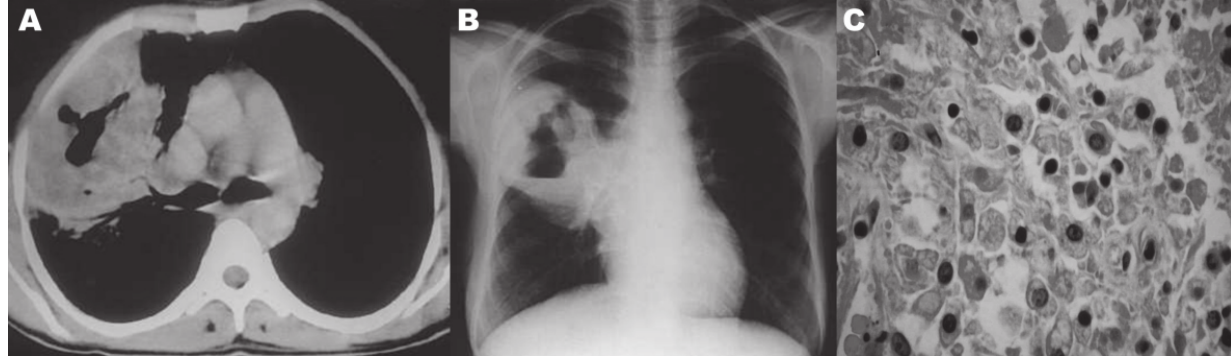
Figure 2 - Thorax CT-scan (A) and Rx-ray (B) of Rhodococcus equi bacteremia with lung abscess. Lung histological section with sheets of macrophages with foamy or abundant granular eosinophilic cytoplasm that contain Michaelis-Gutmann bodies, characterized by visible PAS-positive and diastase- resistant basophilic structures with targetoid-like concentric laminations (C), (HE